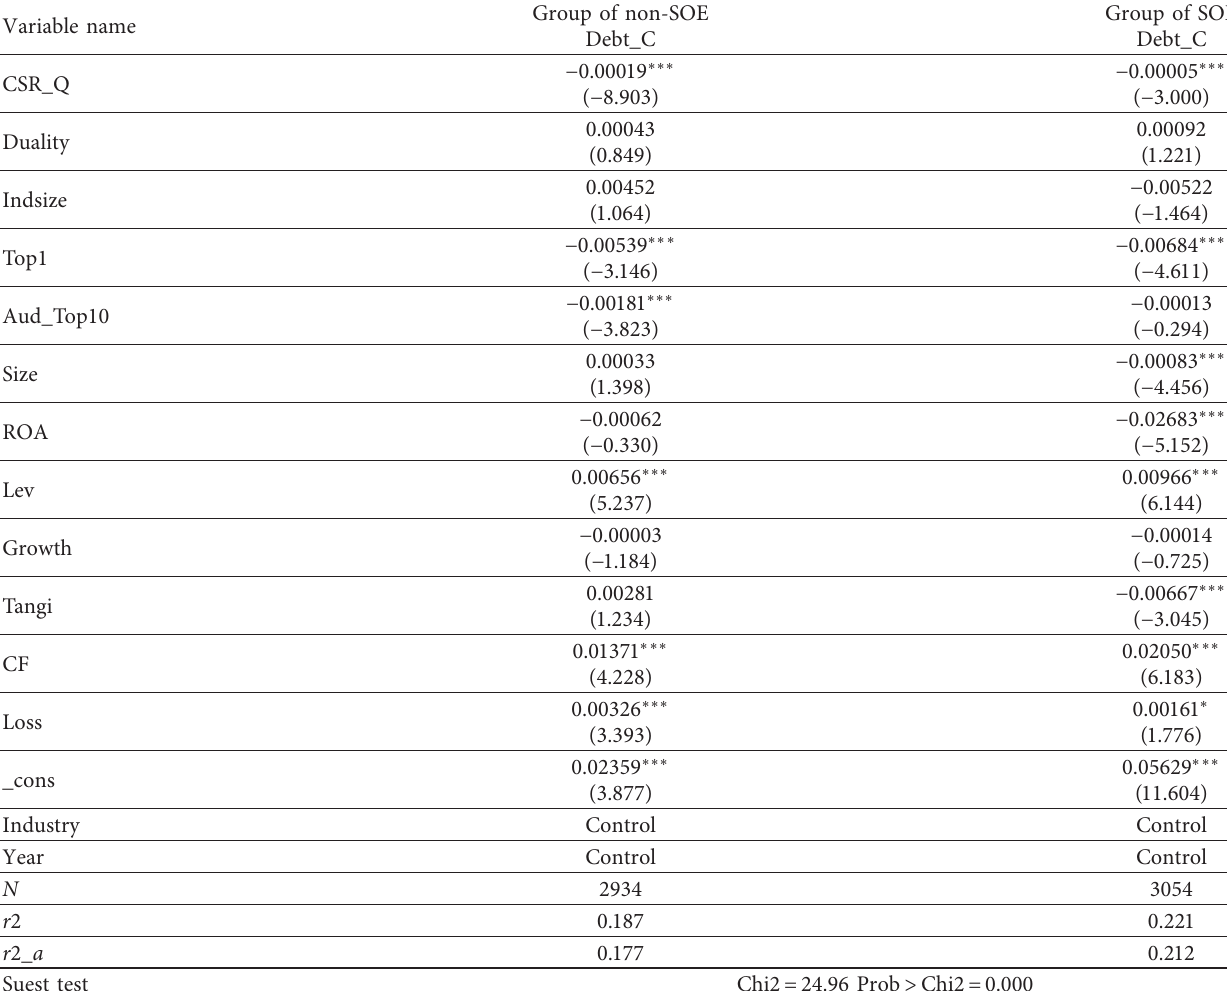
Table 5: Quality of social responsibility disclosure and cost of debt financing: analysis based on the nature of property